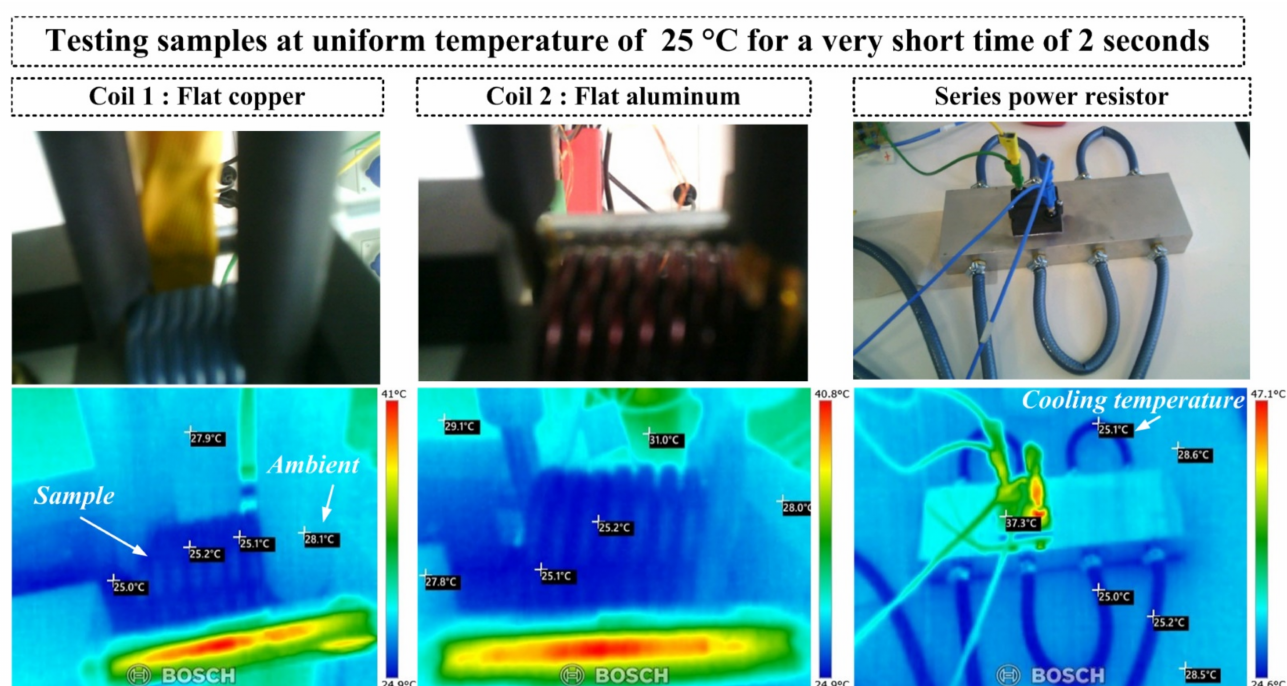
Figure 11. Fast testing approach under forced water cooling at a uniform temperature of 25 ◦ C.